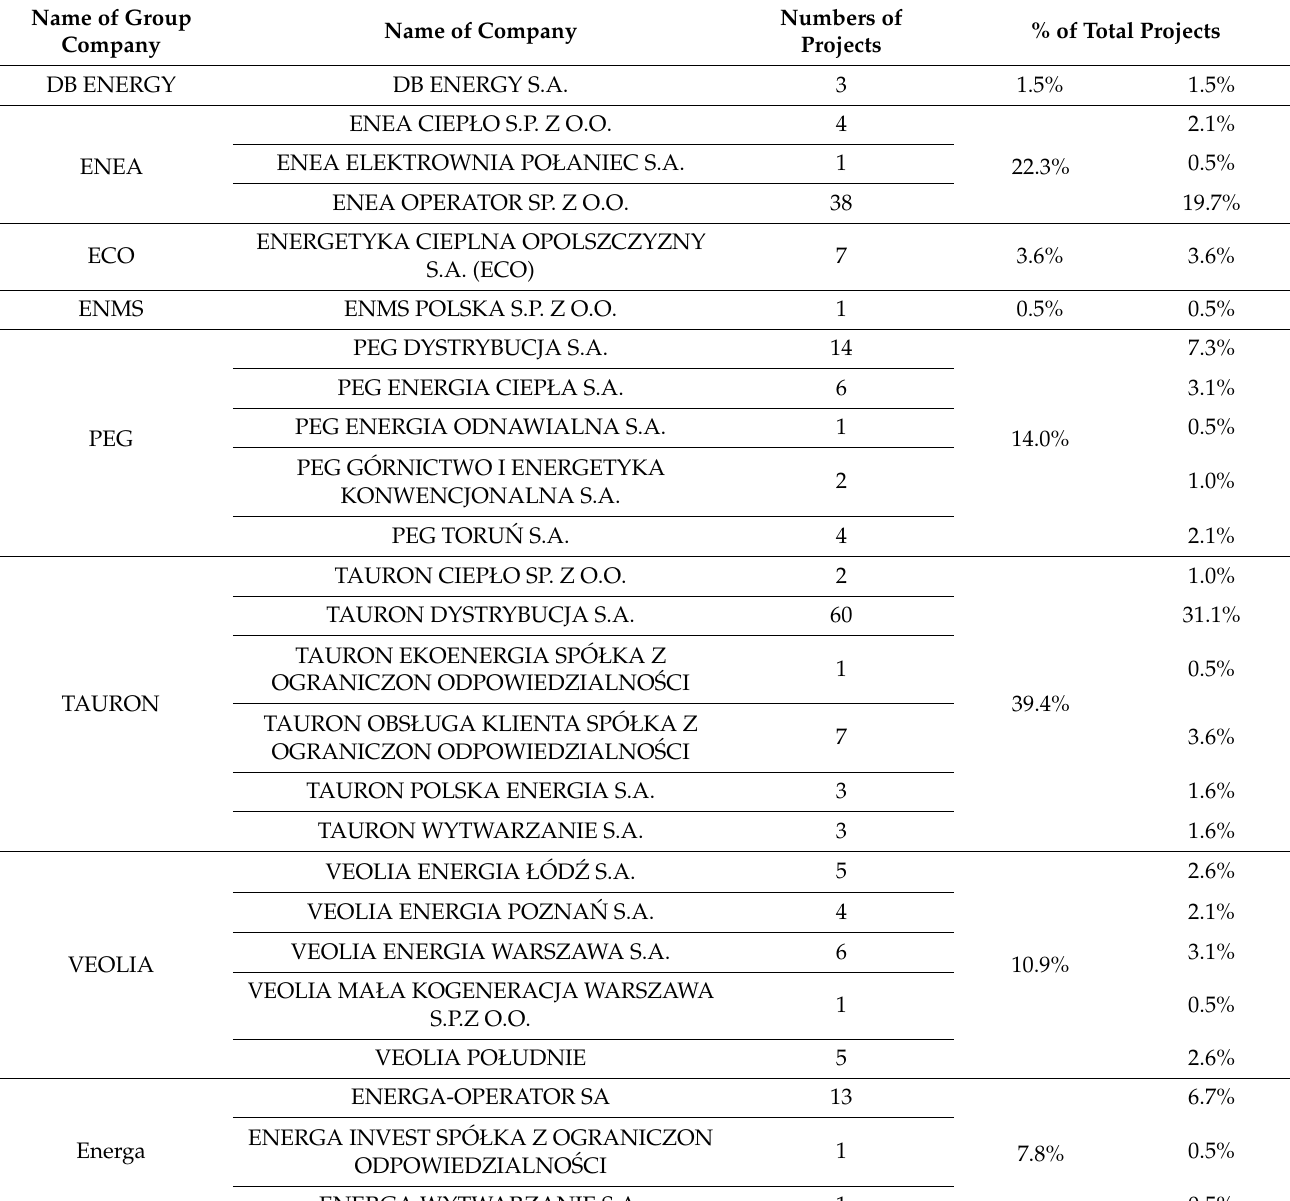
Table 2. Number of projects implemented by the analyzed